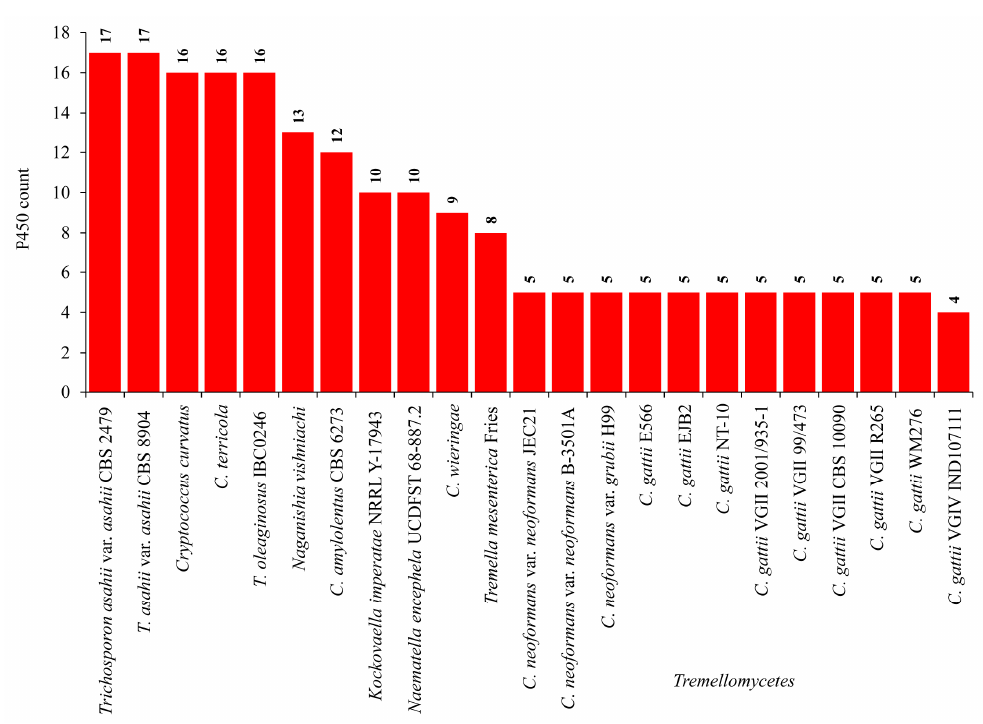
Figure 1. Comparative analysis of CYPs in the species of Tremellomycetes .